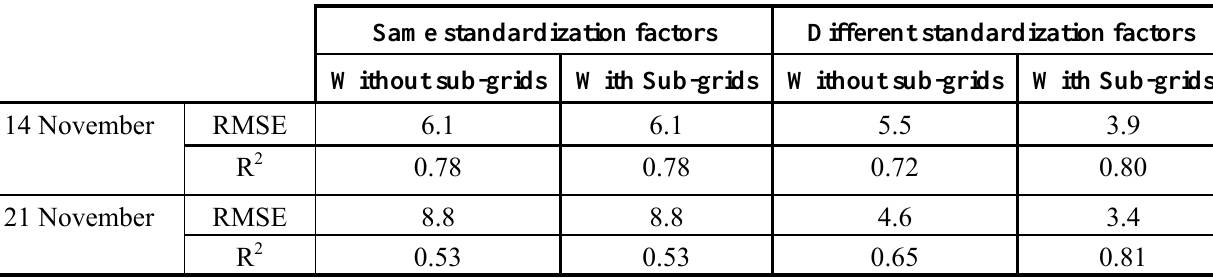
Table 8. Results of using same and different standardization factors from the training data for cases of with and without region divisions.